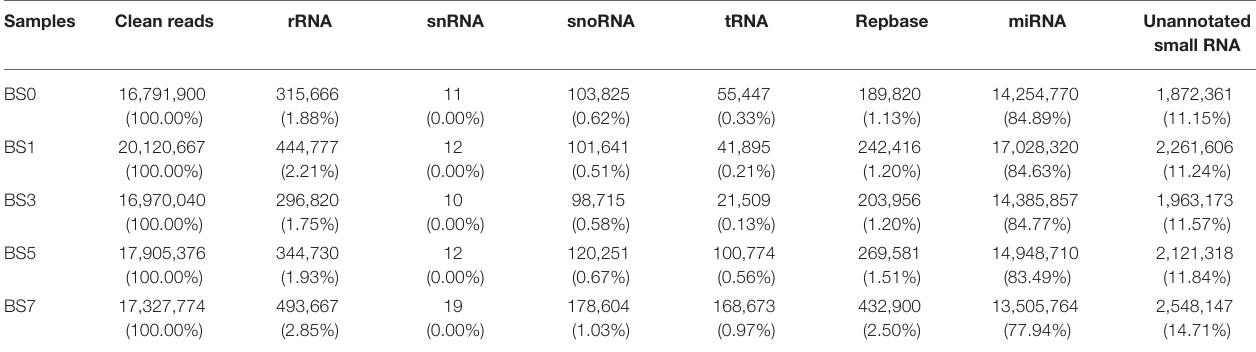
TABLE 2 | Classification and distribution of small RNAs (sRNAs) at different stages of S. aureus -induced mastitis. Samples